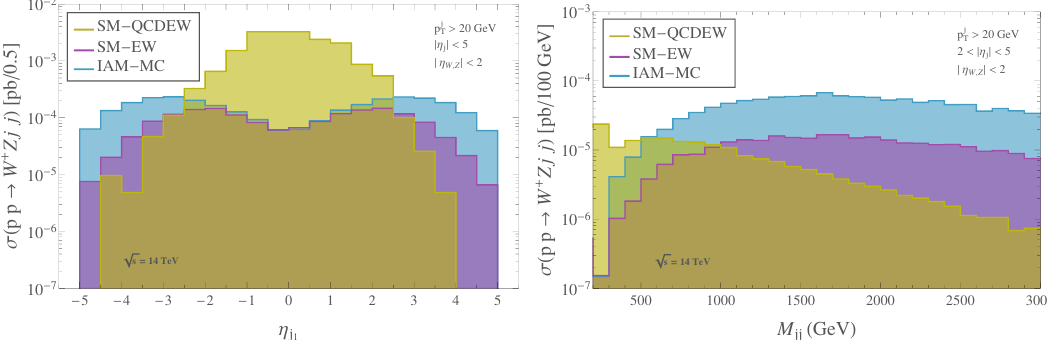
Figure 11 . (cid:27) ( pp W + Zjj ) distributions with the pseudorapidity of the outgoing jet (cid:17) j ! panel) and with the invariant mass of the (cid:12)nal jet pair M jj (right panel). The predictions for the IAM-MC signal for the selected BP1’ scenario (blue) and the two main SM backgrounds, SM- QCDEW (yellow) and SM-EW (purple), are shown